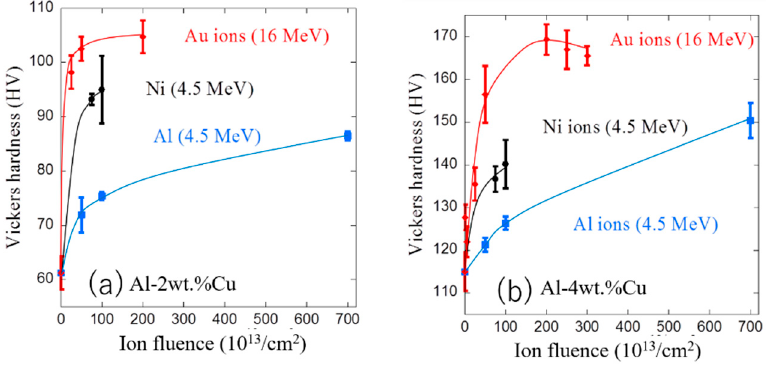
Figure 3. Ion fluence dependence of Vickers hardness of ( a ) Al-2wt %Cu alloy and ( b ) Al-4wt %Cu alloy for three kinds of ion irradiations.